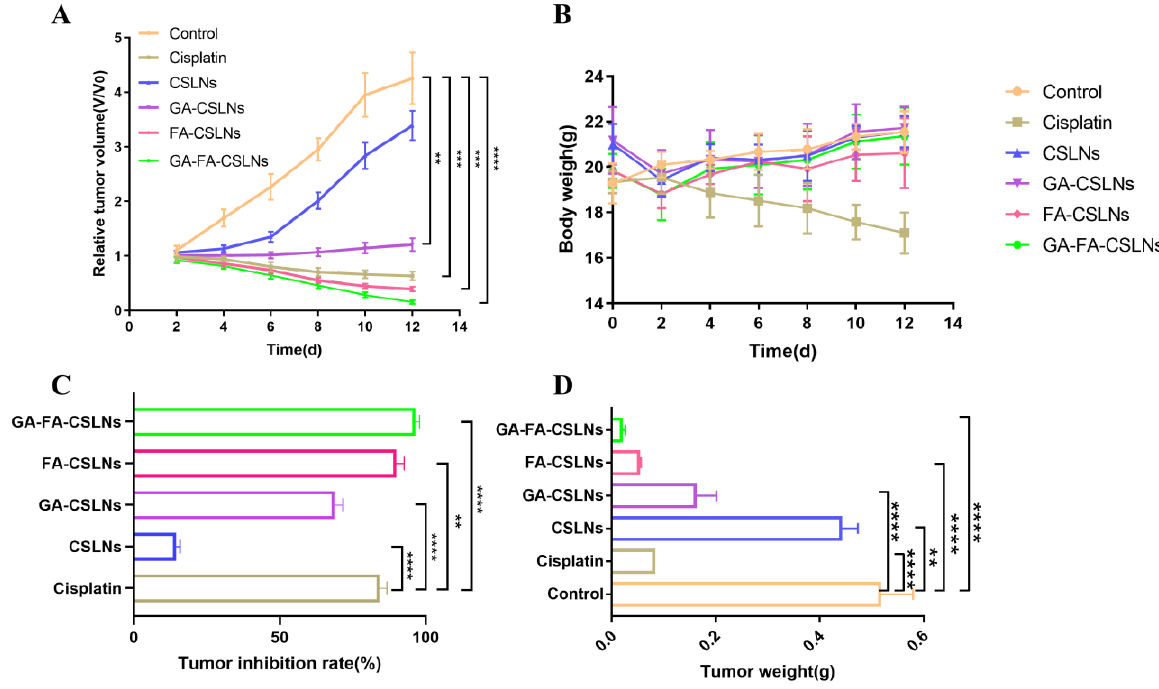
Figure 13. In vivo pharmacodynamic evaluation index of CSLNs ( A ) relative tumor volume; ( B ) body weight; ( C ) tumor inhibition ratio; ( D ) tumor weight. Date is presented as the mean ± SD ( n = 6). ** p < 0.01, *** p < 0.001, and **** p < 0.0001.